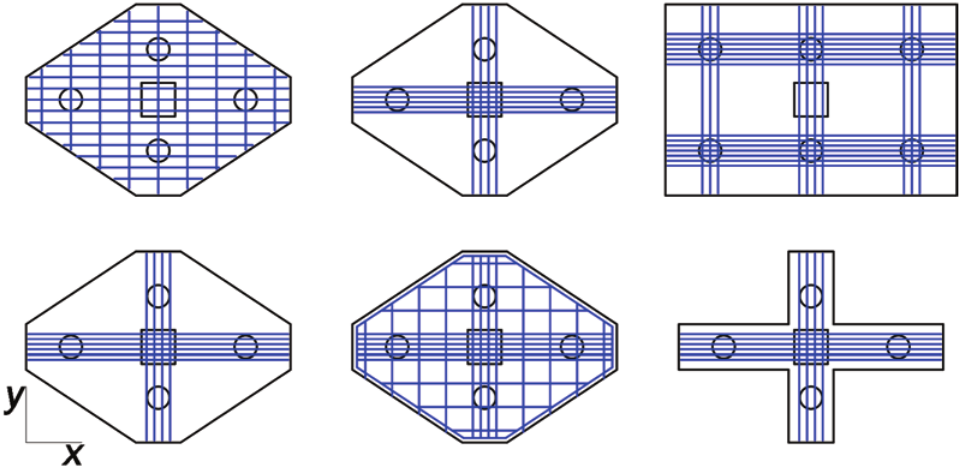
Figura 1 Modelos ensaiados por Adebar et al.